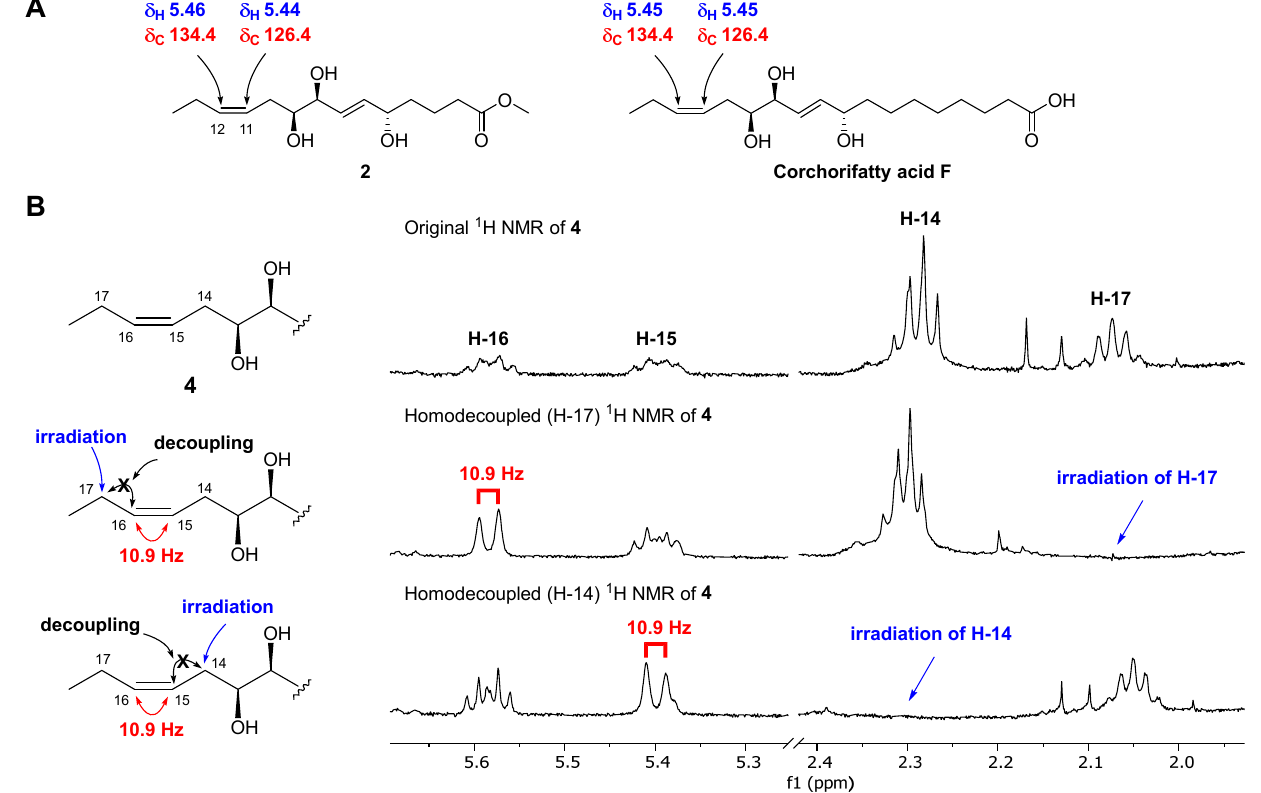
Figure 4. Determination of the geometry of 2 by comparative NMR data analysis measured in methanol- d 4 ( A ) and of 4 by selective homonuclear decoupled 1 H NMR experiments ( B ). The molecular formula of chaenomester C ( 3 ) was determined as C 20 H 38 O 5 by observing the sodiated molecular peak at m/z 381.2612 [M + Na] + (calcd. for C 20 H 38 O 5 Na + , m/z 381.2611) in HRFABMS. Intensive analysis of the 1D NMR data of 3 indicated that 3 would be an ethyl ester derivative of pinellic acid [18], as deduced by the additional ethyl group signals in the NMR spectra of 3 at δ H 4.12 (2H, q, J = 7.1 Hz, H-19) and 1.25 (3H, t, J = 7.1 Hz, H-20) and δ C 60.3 (C-19) and 14.4 (C-20). This initial proposal was supported by the 2D NMR data analysis including a HMBC correlation of H-19/C-1 and a 1 H- 1 H COSY cross-peak of H-19/H-20 (Figure 2). Therefore, the structure of 3 was elucidated as ethyl (9 R *,12 R *,13 R *)-9,12,13-trihydroxy-10 E -octadecenoate. Chaenomester D ( 4 ) showed the molecular formula C 20 H 36 O 5 , supported by the sodiated molecular ion peak at m/z 379.2455 [M + Na] + (calcd. for C 20 H 36 O 5 Na + , m/z 379.2455). The NMR spectra of 4 showed that 4 is similar to 3 , with the major difference of two olefinic signals, δ H 5.58 (1H, m, H-16) and 5.40 (1H, m, H-15) and δ C 135.5 (C-16) and 123.9 (C-15) observed in 4 . The analysis of the 1 H- 1 H COSY and HMBC data of